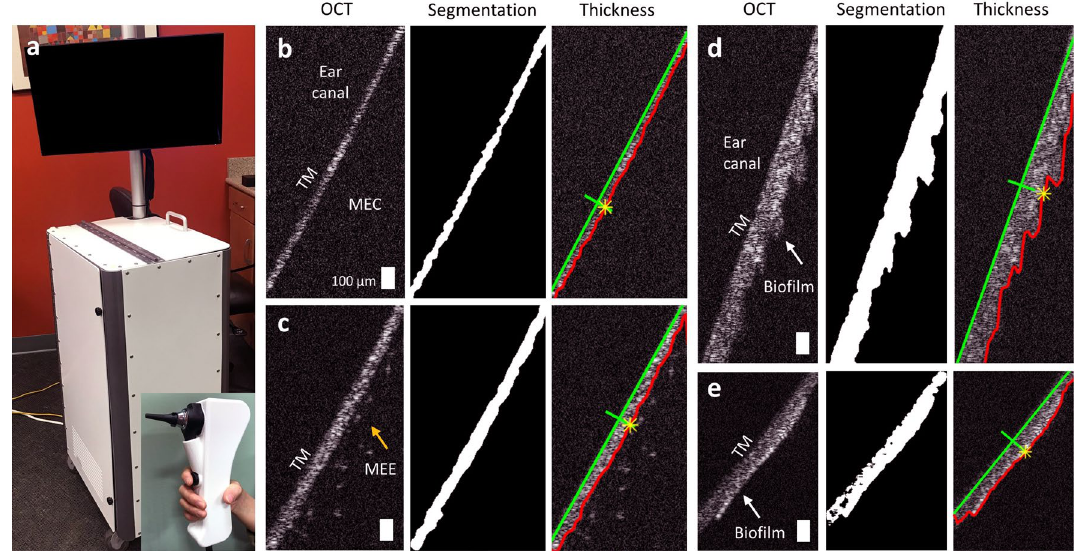
Figure 1. Handheld OCT system for middle ear imaging in the chinchilla model. ( a ) Photo of the OCT system and handheld probe (inset). Representative OCT images showing ( b ) clear middle ear cavity, ( c ) presence of a MEE, and ( d , e ) TM with a biofilm. The TM and any biofilm adherent to the TM was segmented. Next, the orthogonal distance from the green and the red line was measured and corrected for the refractive index (RI) error. Scale bars represent 100 µm. TM tympanic membrane, MEC middle ear cavity, MEE middle ear